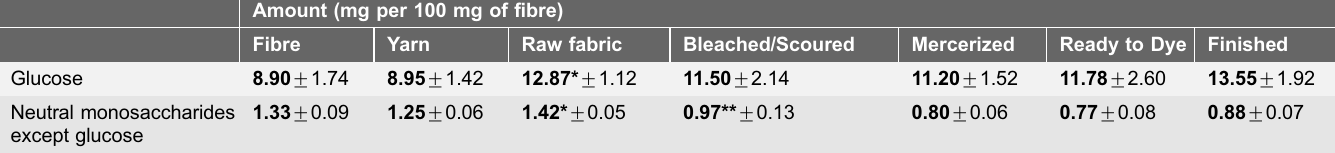
Table 1. Amounts of glucose and total neutral monosaccharides (except glucose) obtained after hydrolysis of powdered textile processing samples. Amount (mg per 100 mg of